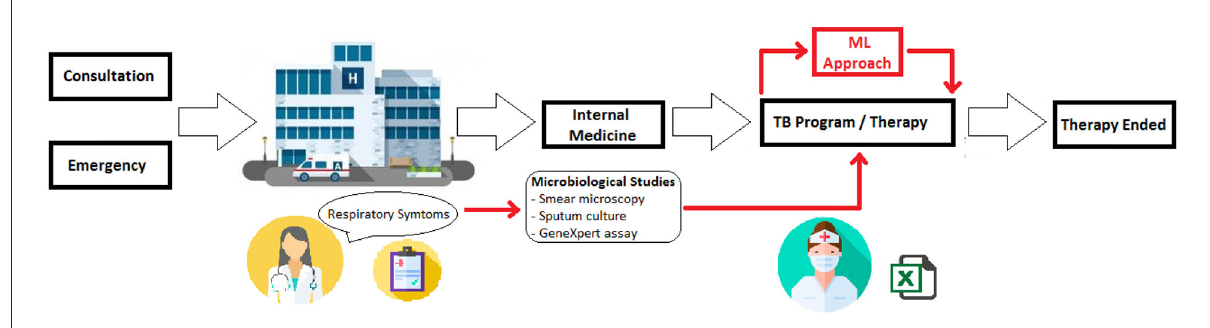
FIGURE1 Schematic of using ML in TB diagnosis. During the TB diagnosis, ML tools are employed to support the decision about the antituberculosis therapy beginning.